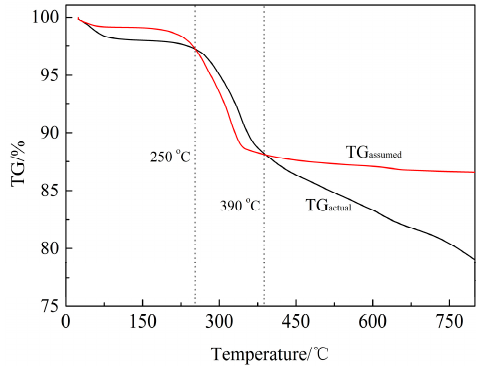
Figure 8. The comparison of the assumed TG curve and actual TG curve.